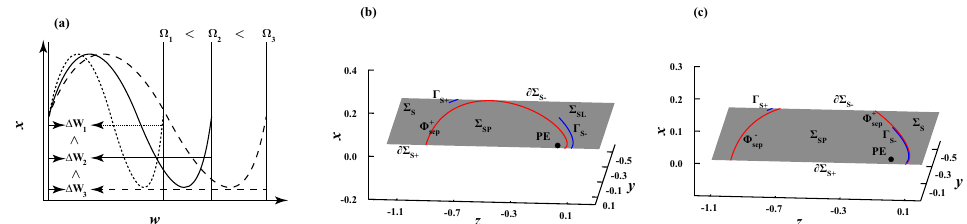
Figure 10. The relationship of DSV ∆ w and excitation frequency Ω as well as the influence on attractor basin structures of rest spike bistability II. ( a ) Sketch map of the relationship of ∆ w and Ω ; ( b ) the attractor basin structures of rest spike bistability II in Figure 9a with ∆ w = 0; ( c ) the attractor basin structures of rest spike bistability II in Figure 9a with ∆ w =